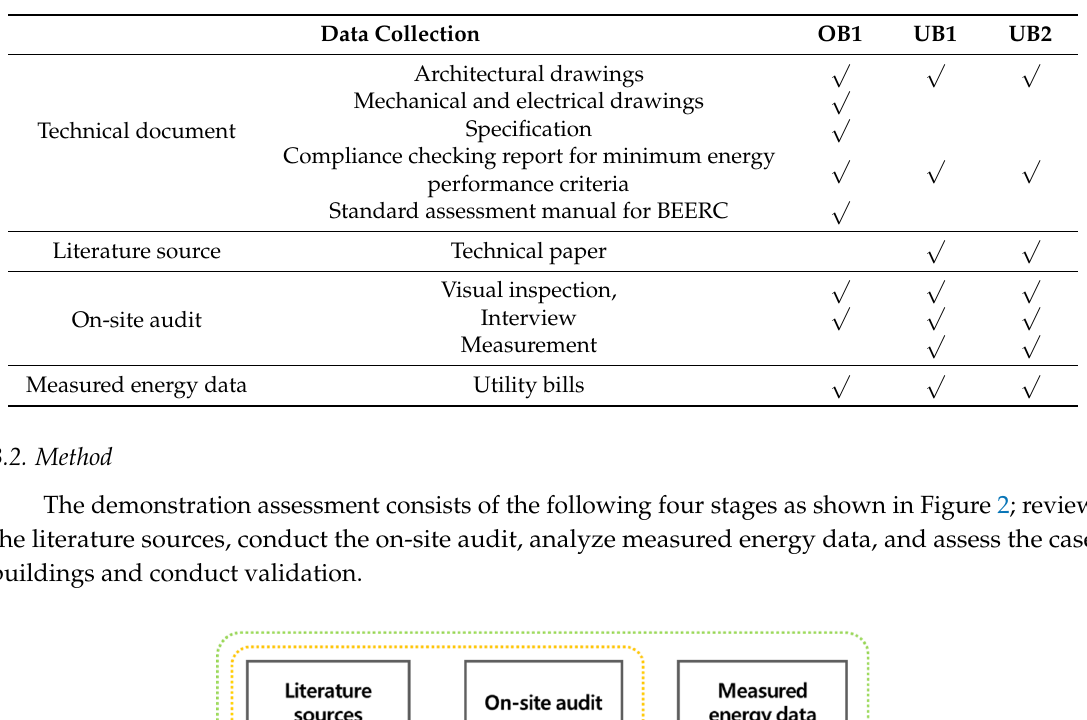
Table 6. Collected data by the buildings studied.